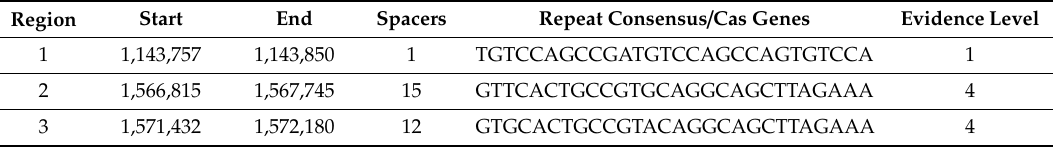
Table 4. Distribution of clustered regularly interspaced short palindromic repeats (CRISPR) regions in genome of Enterobacter sp.